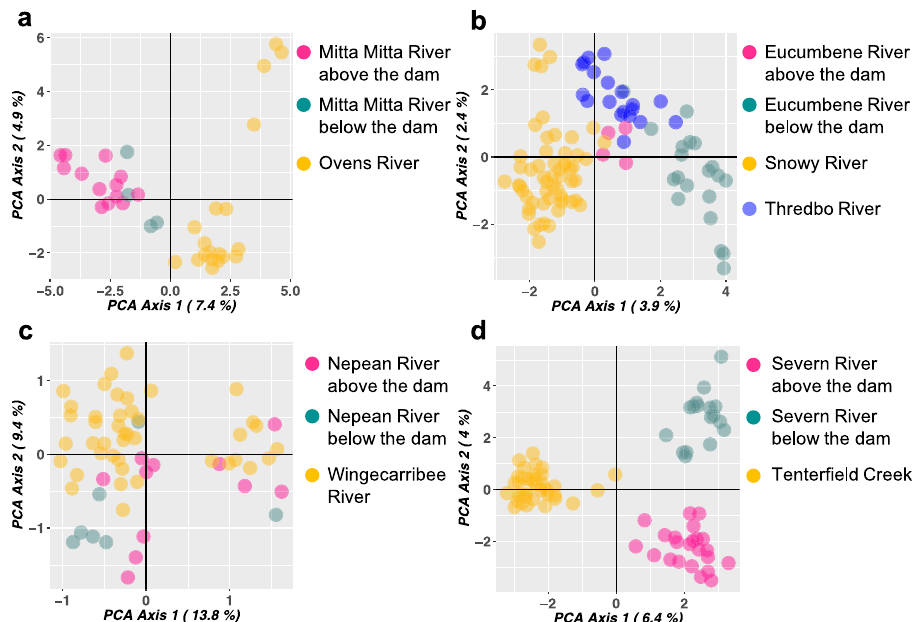
Fig. 3 Principal coordinates analyses. a Upper Murray Rivers: unregulated (no dam) Ovens and regulated (dam) Mitta-Mitta Rivers. b Snowy Rivers: regulated (dam) Snowy, unregulated (no dam) Thredbo and regulated (dam) Eucumbene Rivers. These rivers do not follow the paired experimental design due to geographic constraints. c Central NSW Rivers: regulated (dam) Nepean and unregulated (no dam) Wingecarribee Rivers. d Border Rivers: unregulated (no dam) Tenter fi eld Creek and regulated (dam) Severn River. Numbers between parentheses in the axis labels show the percentage of variation captured by each axis. Each point represents a platypus